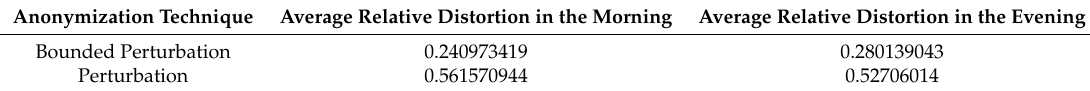
Table 3. Average relative